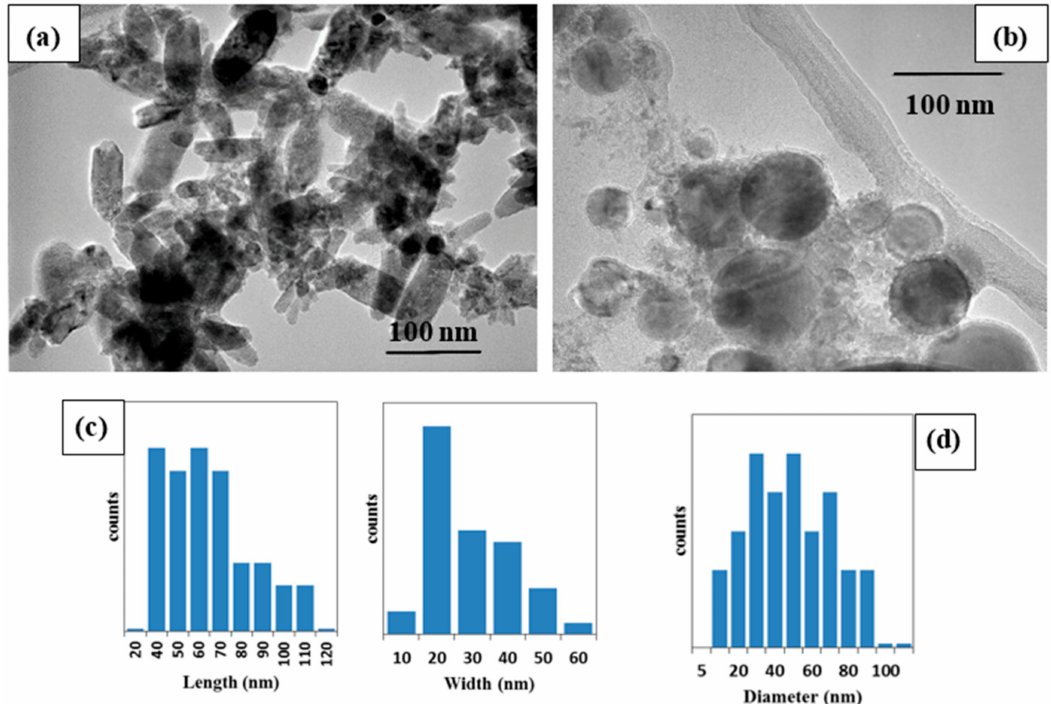
Figure 3. Transmission electron microscopy (TEM) images of ( a ) ms-ZnO nanoparticles